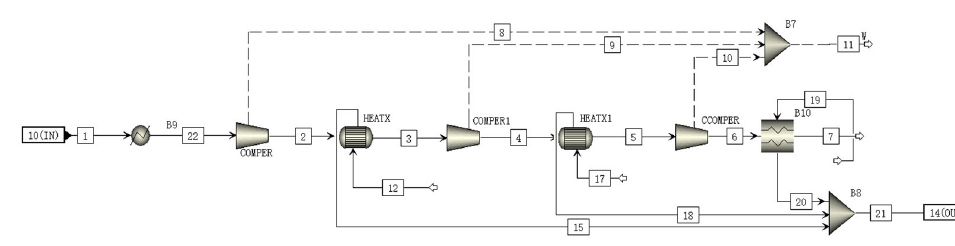
Figure 6. A schematic of the CCS module flowsheet. Table 8. Stream parameters in CCS.